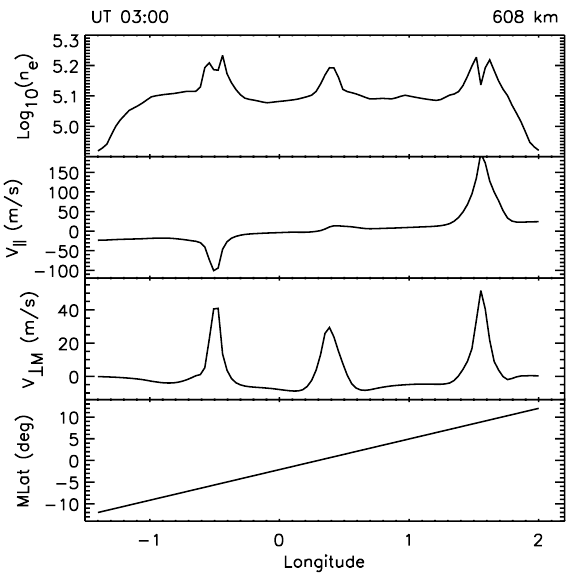
Fig. 5. Plots of log 10 n e , field-aligned O + velocity ( V k , positive = northward), vertical E × B velocity ( V ⊥ M ), and magnetic latitude versus longitude along a trajectory fixed altitude